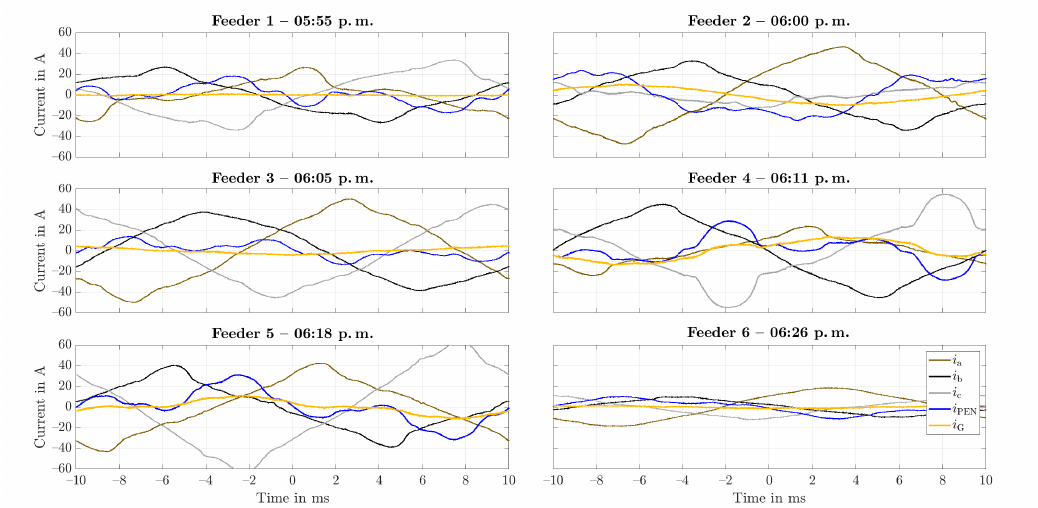
Figure 3. Measurement results from all six feeders at substation D. Due to the small number of measurement samples, it is not possible to draw general conclusions regarding the influence of line type, number of cable cabinets and customers on the share of return current flowing through ground. However, the average of I G / I PEN for feeders with more than ten costumer nodes (0.44) is noticeably higher compared to the one of feeders with less than ten costumer nodes (0.23). A possible explanation is that grounding impedances of costumer nodes provide parallel grounding resistances, which leads to a decreased overall ground return path impedance. Table 1. Current measurements of different feeders at exemplary LV